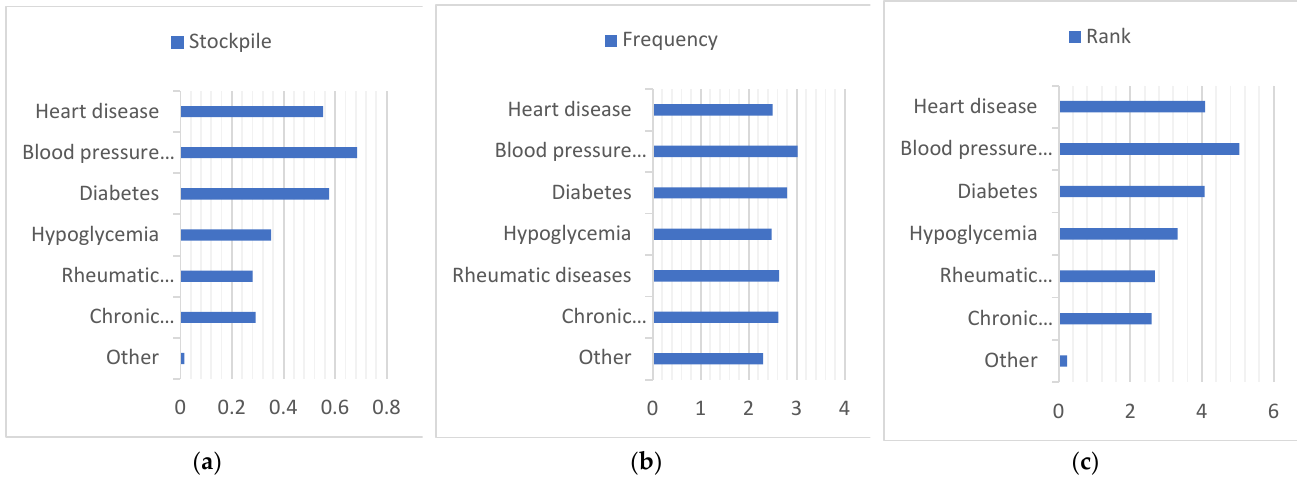
Figure 10. Summary of medication stockpiling, frequency of medication use, and ranking of im- portance of medication for elderly households with elderly members. ( a ) Stockpile , ( b ) Frequency, ( c ) Rank.